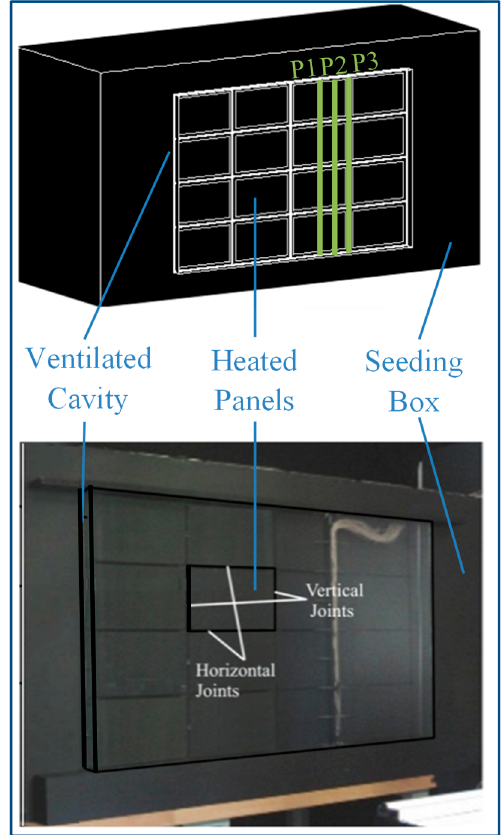
Figure 4. Geometry of the OJVF numerical model (upper part) and experimental laboratory test bench (lower part).